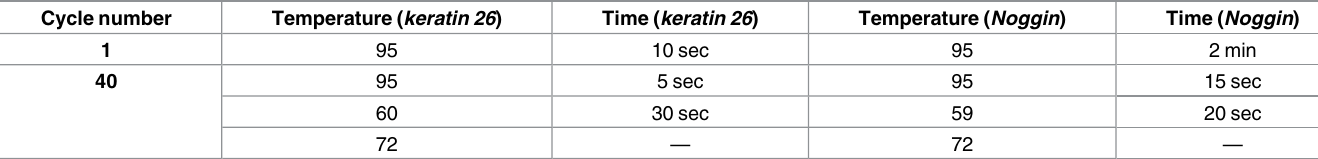
Table 3. Reaction conditions of quantitative real-time